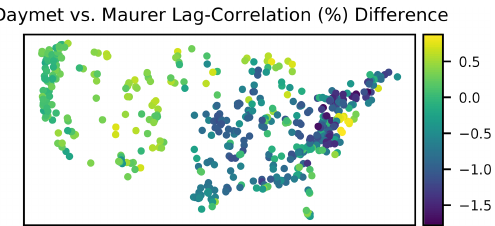
Figure 2. Spatial distributions of lagged vs. non-lagged correlations between Daymet and Maurer test period precipitation. Positive val- ues indicate that the 1d lagged correlation is